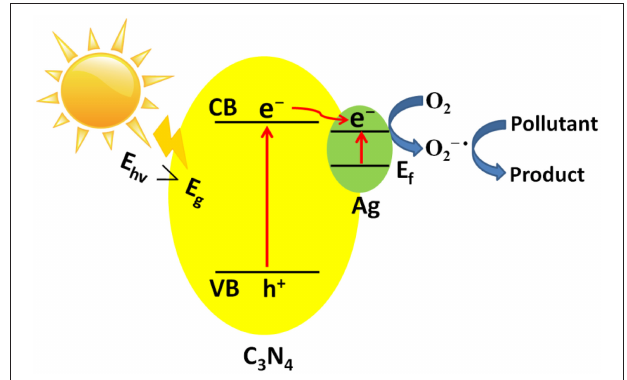
FIGURE 9 | Photocatalytic mechanism of RhB decomposition over Ag/g-C 3 N 4